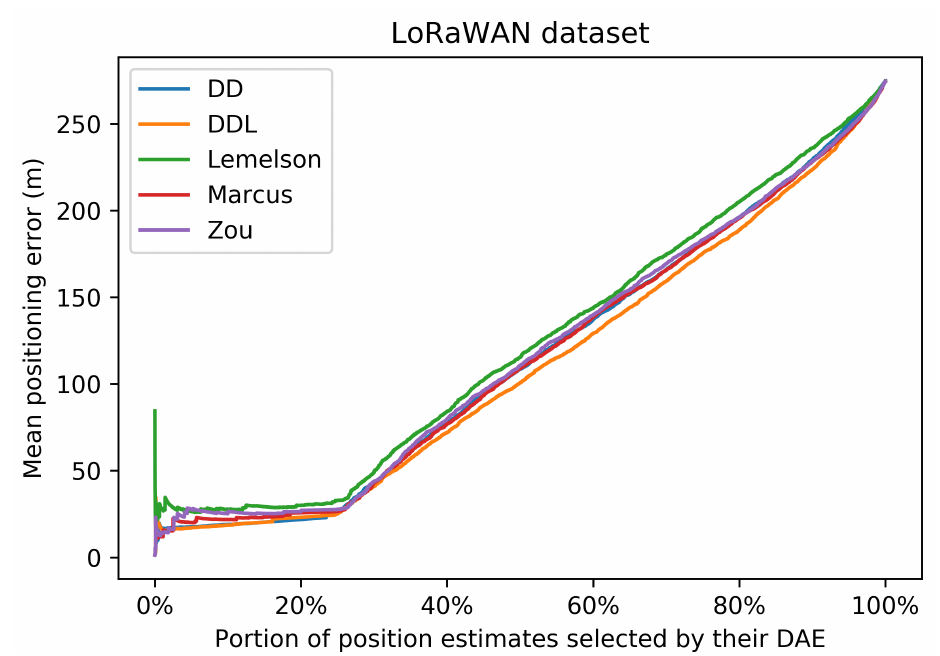
Figure 13. In this plot, the horizontal axis represents the percentage of location estimates selected based on their ranking according to the DAE values. The ranking of each DAE method is depicted with a different color. The vertical axis reports the respective mean positioning error for each selected portion of the original dataset. The values correspond to the validation set of the LoRaWAN